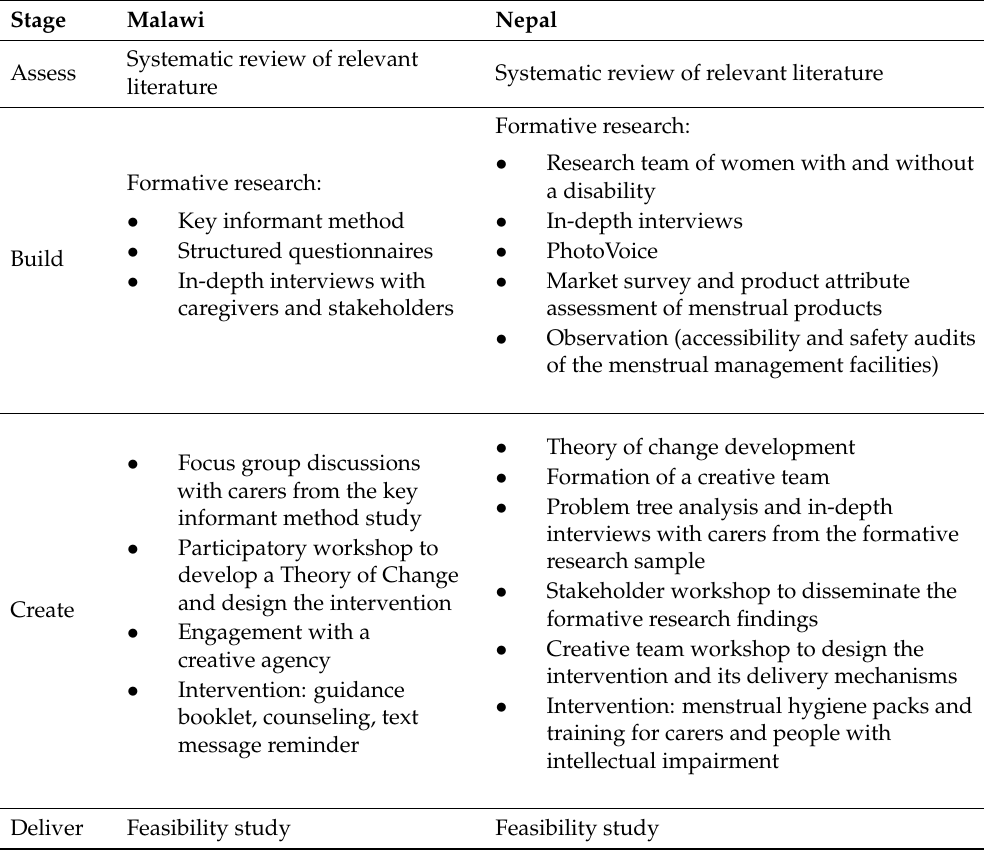
Table 4. Comparison of the processes followed in Malawi and